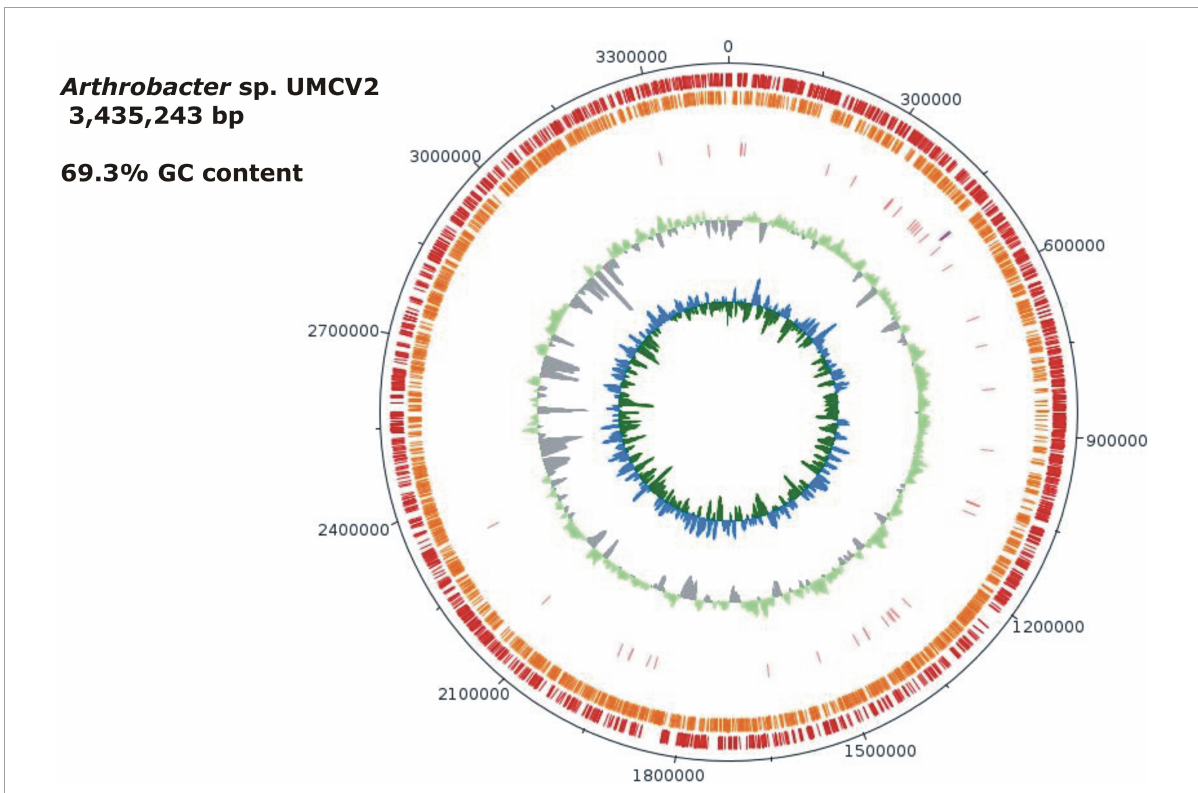
FIGURE1 Graphical map of the Arthrobacter sp. UMCV2. From outside to the center: genes on the forward strand (red), genes on the reverse strand (orange), RNA genes (pink tRNAs, purple rRNAs), the guanine-cytosine (GC) ratio is in light green and gray. The inner circle shows the GC skew in blue and green. Gaps between individual contigs are not presented. The order of the contigs was assumed to correspond to a reference genome. Contigs not matching the reference genome were ordered from the largest to the smallest. Ordered contigs were joined with 50 bp of “N.” This figure was drawn with the DNA plotter software.